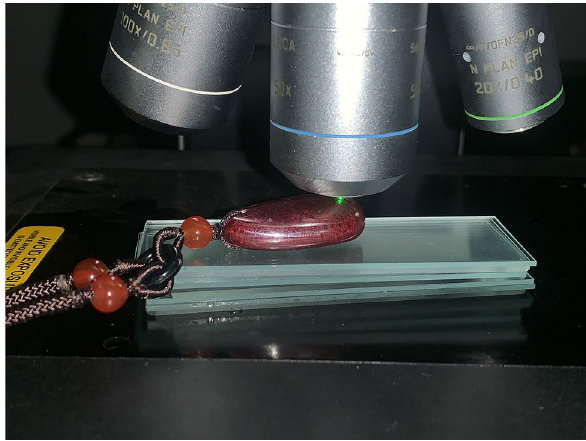
Fig. 6 Micro-Raman experiment scene for the raw mineral sample